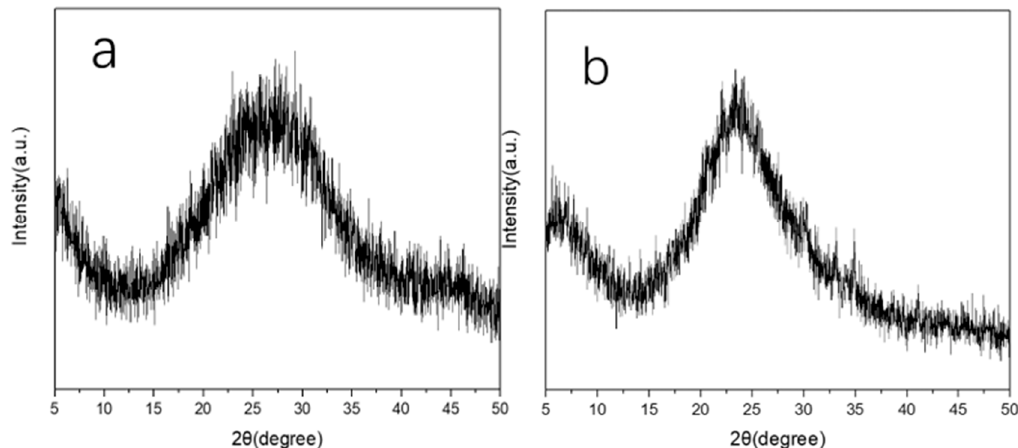
Figure 1. X-ray powder diffraction (XRD) patterns of sample ( a ) SiAl-1 and ( b ) SiAl-2.